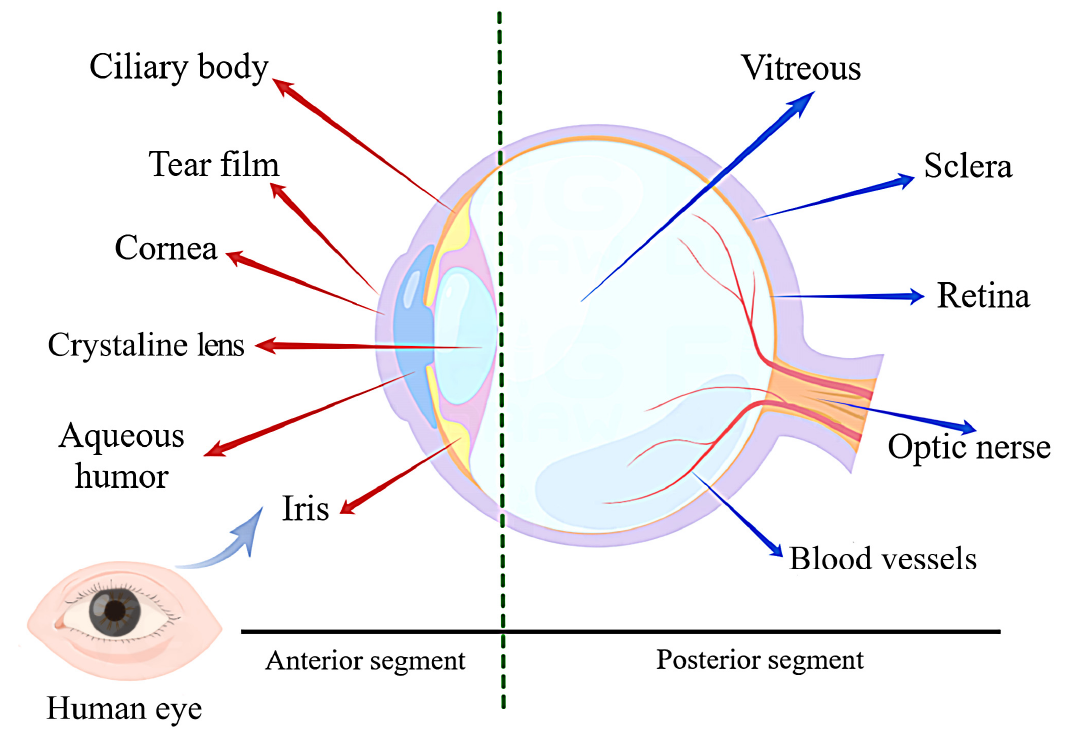
Figure 1. Schematic representation of the ocular structure. The eye consists of two parts: the anterior segment and the posterior segment. The anterior segment includes the cornea, conjunctiva, iris, ciliary body, crystalline lens, and aqueous humor; the posterior segment includes the sclera, choroid, retina, and vitreous humor. They are the main barriers to ocular drug delivery. The cornea, which is located at the front of the eye, is transparent and round in shape and is primarily composed of avascular connective tissue [27]. In addition to protecting the eye from foreign microorganisms, the cornea is known as the largest static barrier that restricts drug molecules from entering the eye [28]. Physiologically, the cornea is divided by scholars into five layers: the epithelium, Bowman’s membrane, stroma, Descemet’s membrane, and inner endothelium [29]. The epithelium and endothelium are made up of multiple layers of cells that prevent hydrophilic molecules from entering the aqueous humor while allowing lipophilic molecules to pass through, whereas the stroma between the epithelium and endothelium is made up of hydrophilic collagen and thus prevents the passage of lipophilic molecules while allowing the osmotic diffusion of hydrophilic molecules [30]. The “sandwich” structure of the cornea, which is hydrophobic on both sides and hydrophilic in the middle, requires a large distribution coefficient of drugs in both the water and oil phases, so it also determines the physical and chemical properties of drugs entering the cornea. In addition, the cornea has a mechanism for the self regulation of pH, known as the “tear buffer system.” The acid–base balance on the corneal surface will be broken, and ocular diseases may further deteriorate when the quantity or quality of tear fluids is decreased.